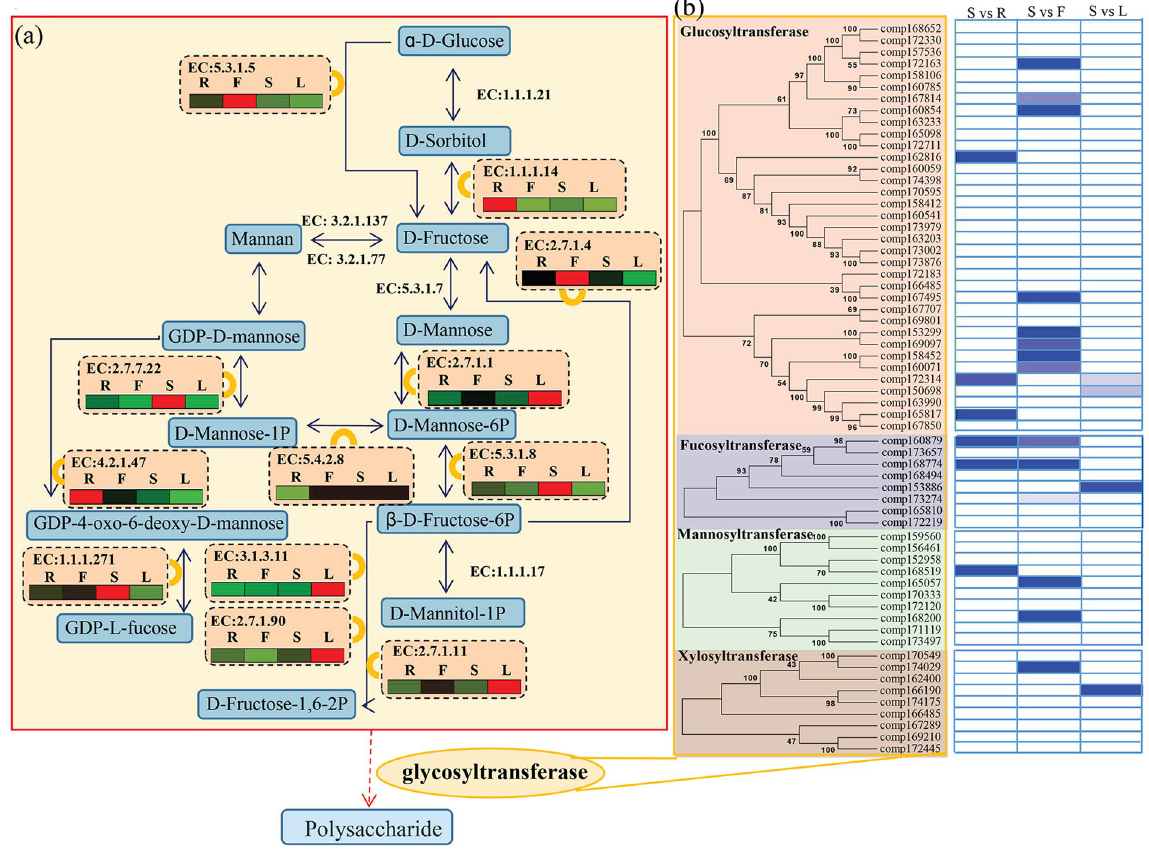
Figure 4. Expression patterns of the putative fructose and mannose metabolism unigenes in D. officinale . ( a ) The pathway of fructose and mannose metabolism is based on KEGG analysis. The full names of enzymes by EC IDs are provided in Table S5. The average expression level of the enzyme encoding unigenes in various organs is indicated by a heat map. The grids with different colors from green to red show the relative expression levels to maximum RPKM values, from 0 to 100%, respectively. ( b ) Significance analysis of glycosyltransferase unigenes in three stem contained comparisons, including S vs R, S vs F and S vs L. The grids with different shades of blue show the different significant values, from 0 to